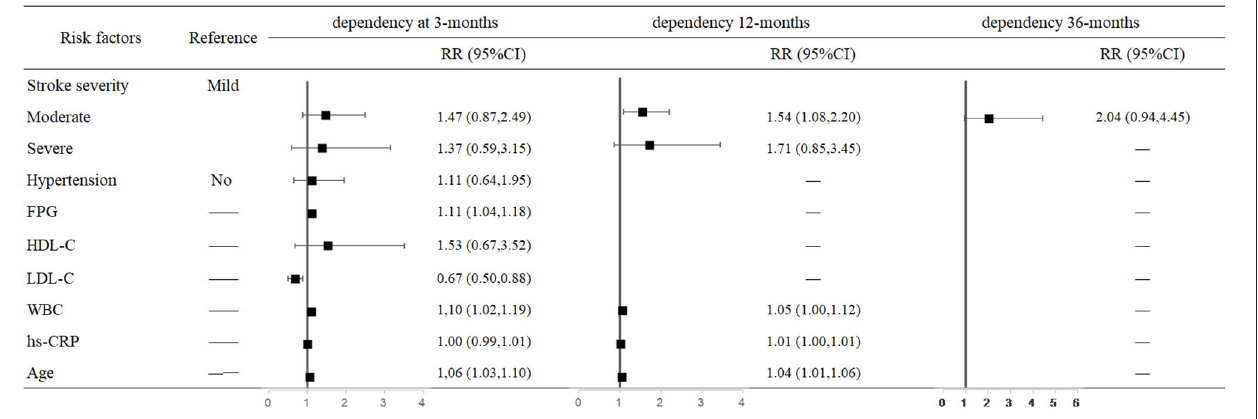
FIGURE 3 | Predictors of dependency at 3, 12, and 36 months after stroke in the multivariate